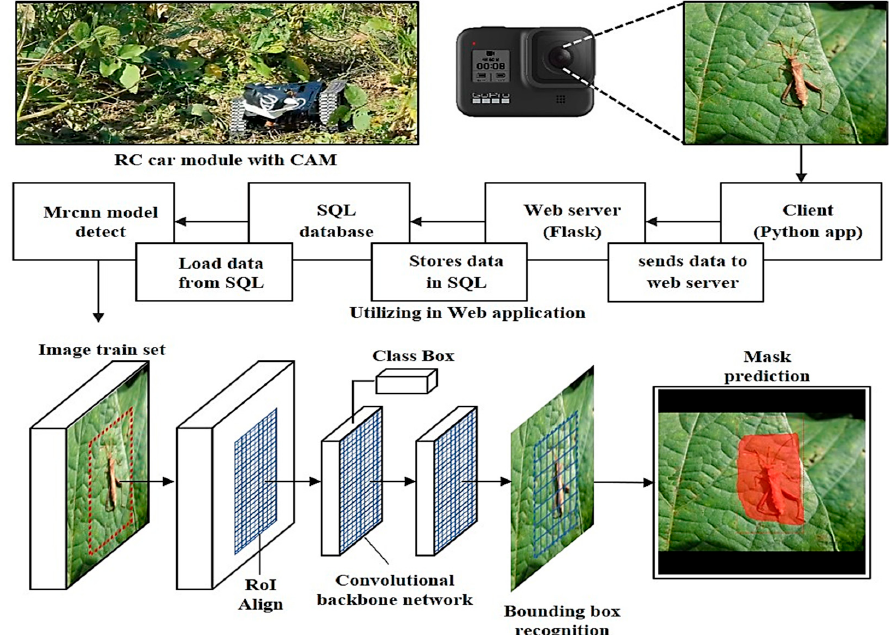
Figure 1. Mask RCNN architecture. An unmanned ground vehicle (UGV) was used to detect the distribution and pattern of R. pedestris in the field. To collect image samples of R. pedestris , the UGV performed low-floor photography. Pests can be detected as a result of artificial intelligence learning through convolutional neural networks in apps and computer devices using the collected data.